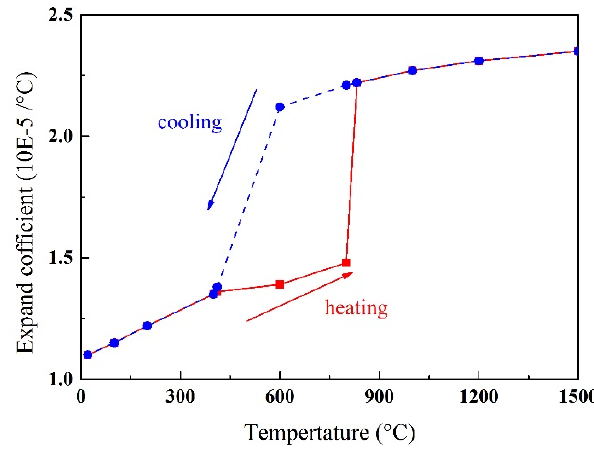
Figure 5. Description of thermal expansion coefficient.